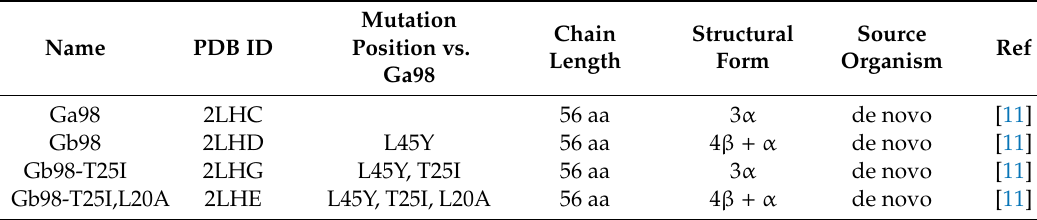
Table 1. Proteins being the object of analysis in the present work. Their short characteristics are also